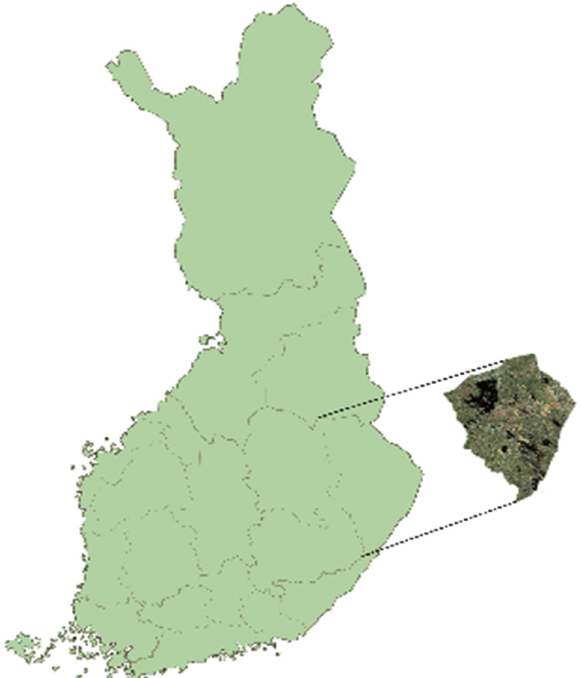
Figure 1. Study area in Northern Karelia.